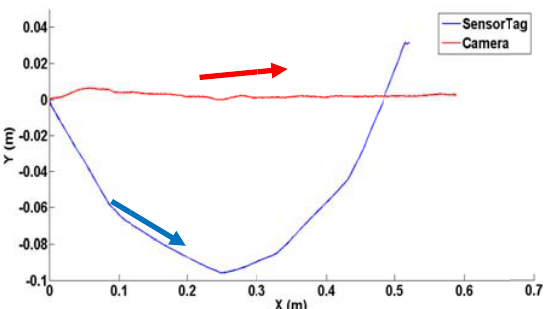
Figure 11. F hown. The “ ures are disti